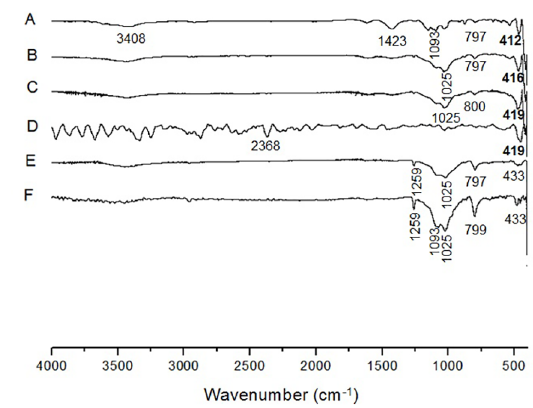
atmosphere: 1) Figure 3. Infrared spectra of the samples treated in the CO 2